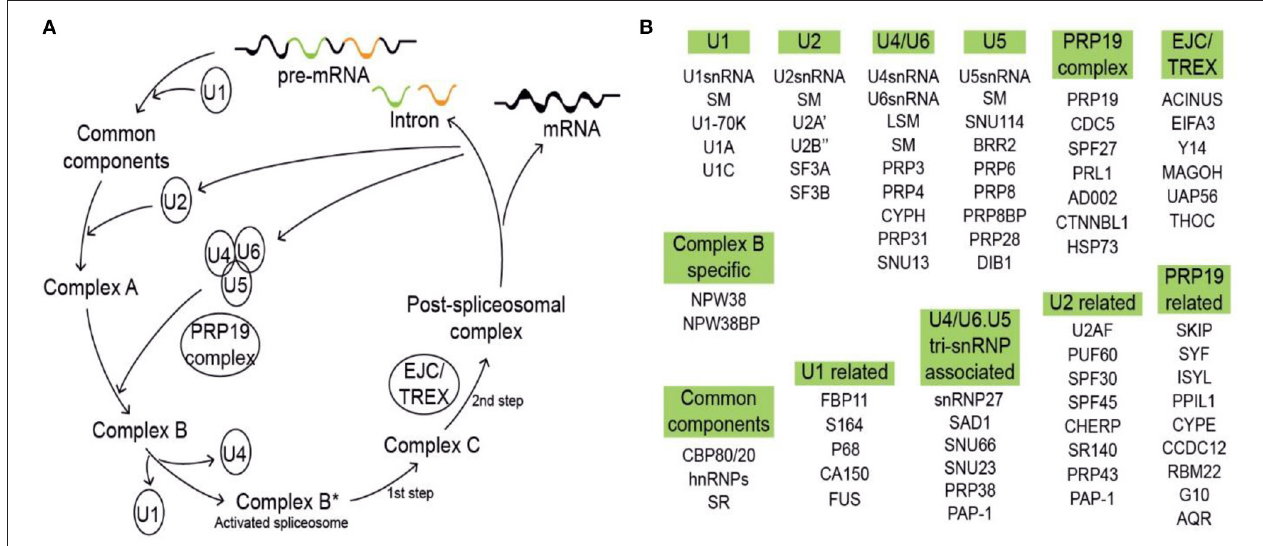
FIGURE 1 | Model of pre-mRNA splicing process (drawn based on https://www.kegg.jp/pathway/map03040). (A) The process of pre-mRNA splicing. The initial step of splice-site recognition comprises U1 small nuclear ribonucleoprotein particle (snRNP) binding to the 5 ′ splice site and U2 auxiliary factor (U2AF) binding to the 3 ′ splice site. U2AF35, the small subunit of U2AF, binds to the intron/exon border, whereas the large subunit U2AF65 binds to a region rich in pyrimidines designated the polypyrimidine tract. Subsequently, U2 snRNP binds to the branch point, and a preformed complex of U4, U5, and U6 snRNPs is recruited to the intron. After major rearrangements and release of the U1 and U4 snRNPs, the splicing reaction takes place. (B) All spliceosomal components are grouped by category, including U1, U2, U4/U6, U5, PRP19 complex, EJC/TREX, U1 related, U2 related, PRP19 related, U4/U6, U5 tri-snRNP associated, and common